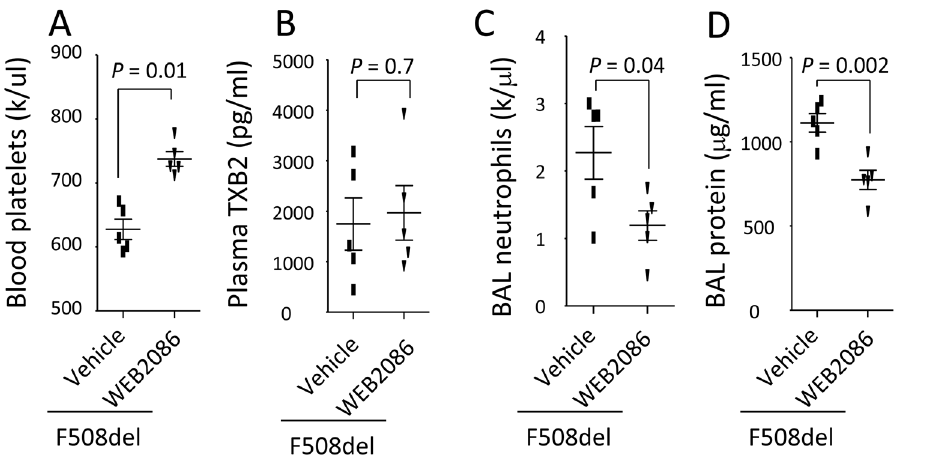
Figure 6. Blockade of PAF by WEB2086 prevents thrombocytopenia in F508del and lung inflammation induced by LPS. A . Blockade of PAF by WEB2086 prevented thrombocytopenia ; but did not affect plasma TXB2 levels ( B ). C–D . Blockade of PAF by WEB2086 reduced BAL neutrophils ( C ) and protein levels ( D ) in F508del mice under LPS challenge. N=5 in each group. Data were analyzed by t-test and presented in mean 6 SD. P values are listed on each panel.